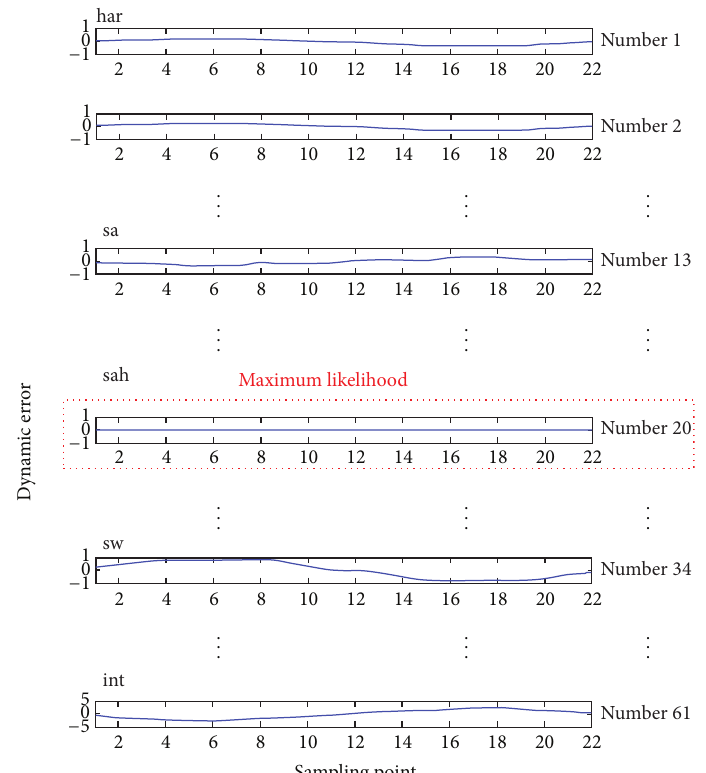
Figure 7: The maximum matching likelihood among different patterns. Note: har : Number 1 ∼ Number 7, sa : Number 8 ∼ Number 18, sah : Number 19 ∼ Number 29, sw : Number 30 ∼ Number 40, swh : Number 41 ∼ Number 51, nor : Number 52 ∼ Number 58, and int : Number 59 ∼ Number 61.